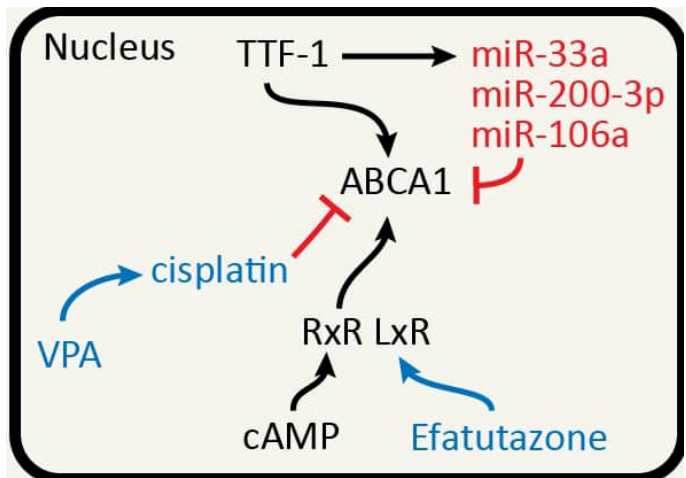
Figure 2. The connection between TTF-1 and ABCA1. ABCA1 has been shown to be negatively regulated through miRNAs including miR-33a, miR-200-3p, and miR-106a. Lai et al. suggested that TTF-1, miR-33a, and ABCA1 may form an incoherent feed-forward loop (TTF-1 → ABCA1; TTF-1 → miR-33a—|ABCA1) [22]. Treatment with Valproic Acid (VPA) enhanced cisplatin sensitivity of non-small-cell lung cancer (NSCLC) cells via HDAC2 mediated down-regulation of ABCA1. Efatutazone treatment increased mRNA and protein expression of PPAR-gamma, LxR-alpha and ABCA1, suggesting that Efatutazone functions through PPAR-gamma/LxR-alpha/ABCA1 pathway. cAMP also can regulate ABCA1 expression. The fact that TTF-1 is a lung lineage master regulator highlights the fact that cholesterol efflux factors may be regulated in a tissue-specific manner.